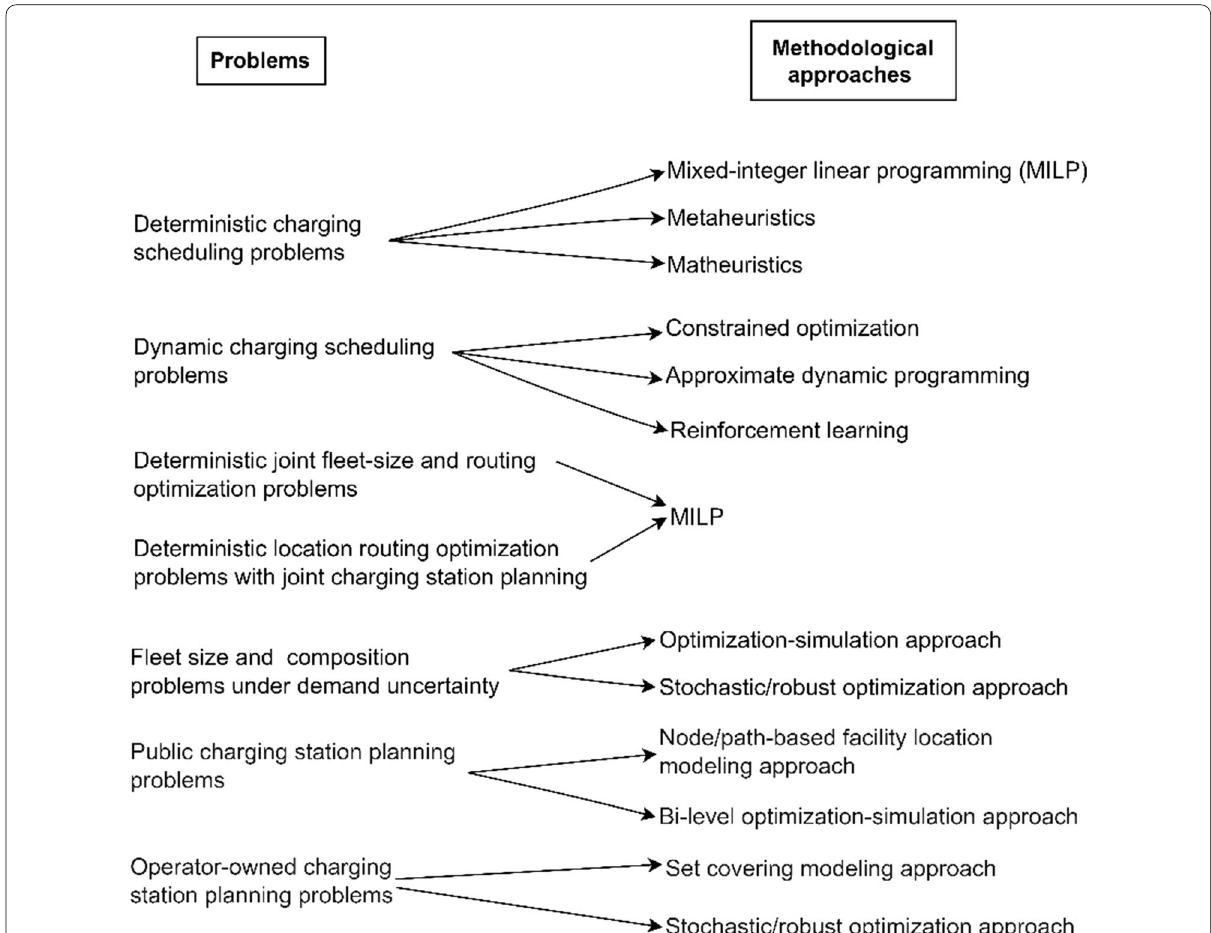
Fig. 3 Types of problems addressed and their methodological approaches for EV‑DRT system